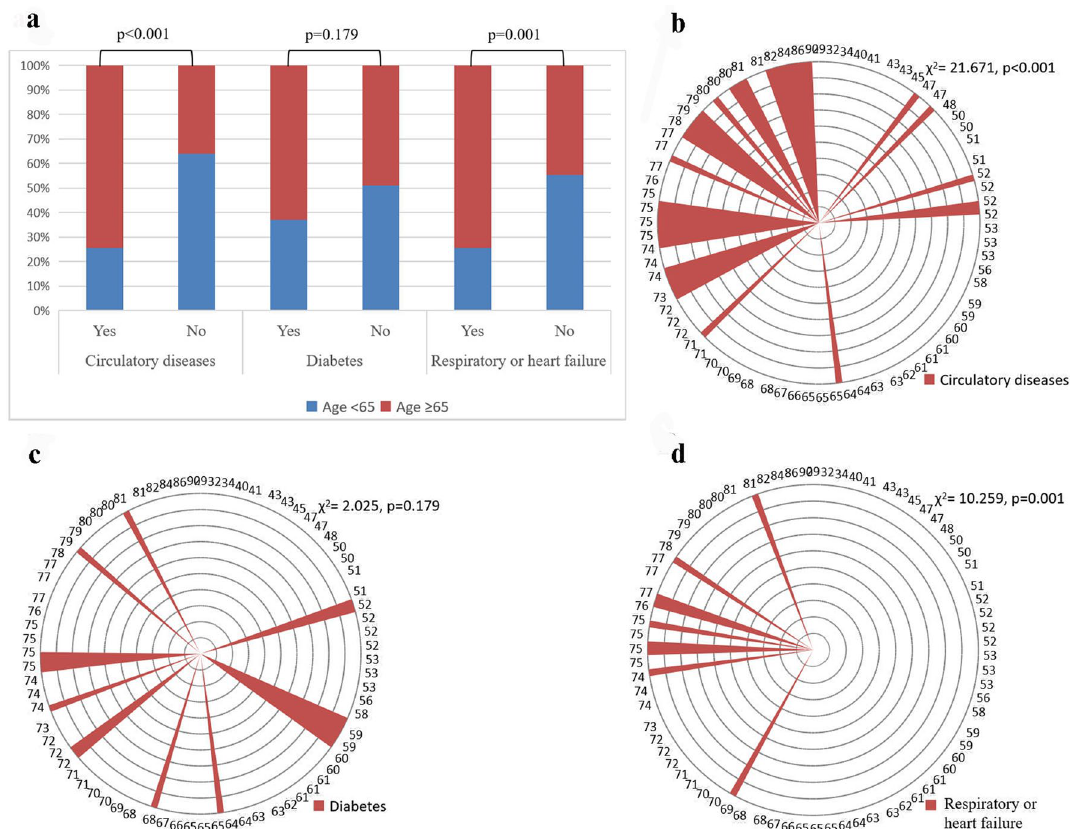
Figure 3. Relationship between concomitant diseases and age. ( a ) Relationship between concomitant diseases and age; ( b ) Relationship between age and diseases of the circulatory system; ( c ) Relationship between age and diabetes; ( d ) Relationship between age and respiratory or heart